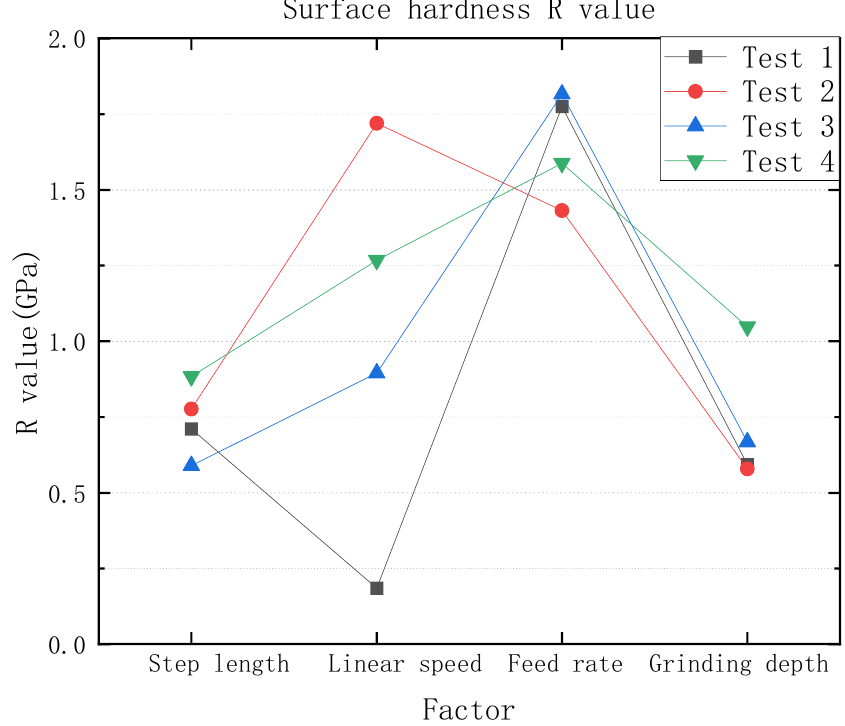
Figure 9. Surface hardness graph for polarization analysis.